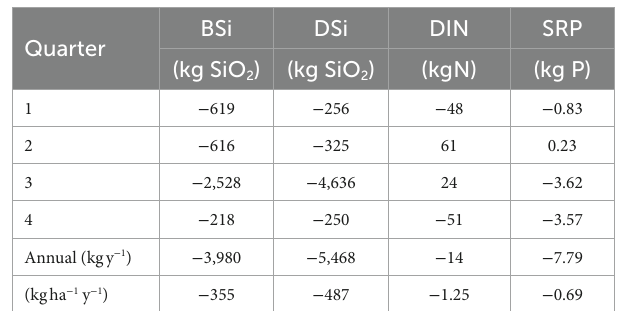
TABLE 4 Estimates of net quarterly and annual fluxes of dissolved Si (DSi) and biogenic Si (BSi) in kg SiO 2 , total dissolved nitrogen (TDN, kg N) and soluble reactive phosphorus (SRP, kg P) at the Cell 1B inlet, Poplar Island, Chesapeake Bay, in 2014.